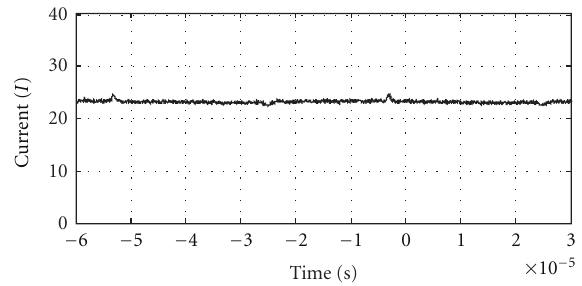
Figure 9: The output current of system with second order sliding